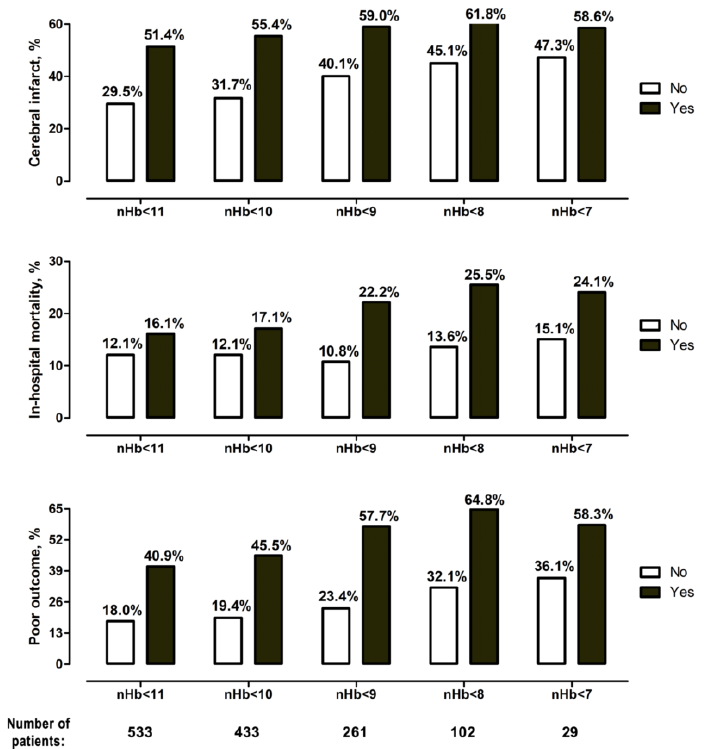
Table 3. Overview of univariate and multivariate analyses for every nadir Hb level.